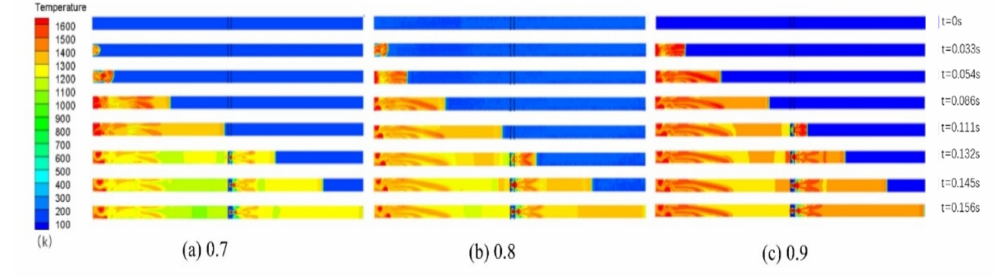
Figure 14. Comparison of temperature cloud of metal foam with different porosities.